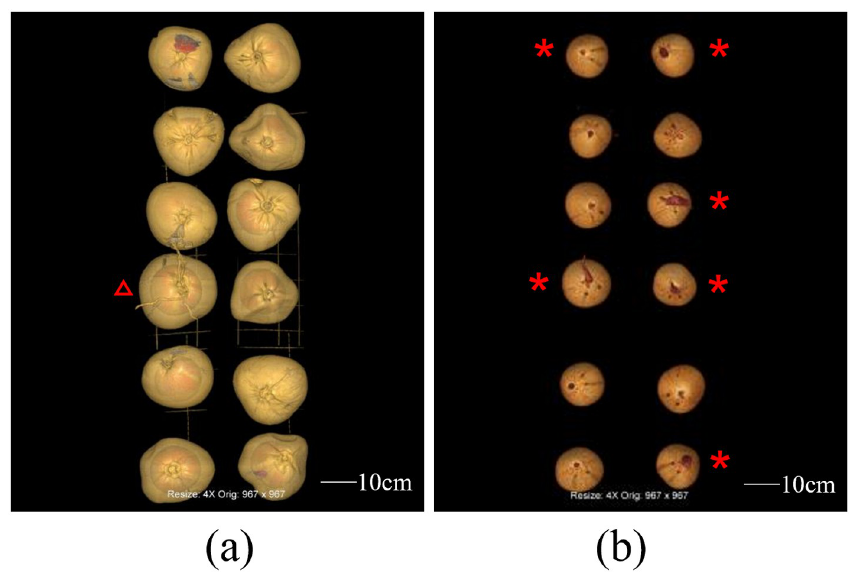
Fig 3. Different volume rendering models for displaying the overall condition of the coconuts in the first scan. (a) The exocarp of the coconut, with a coconut sprout visible on the exocarp (red triangle). (b) The endocarp of coconuts, bud merged from the largest pore (red asterisk).